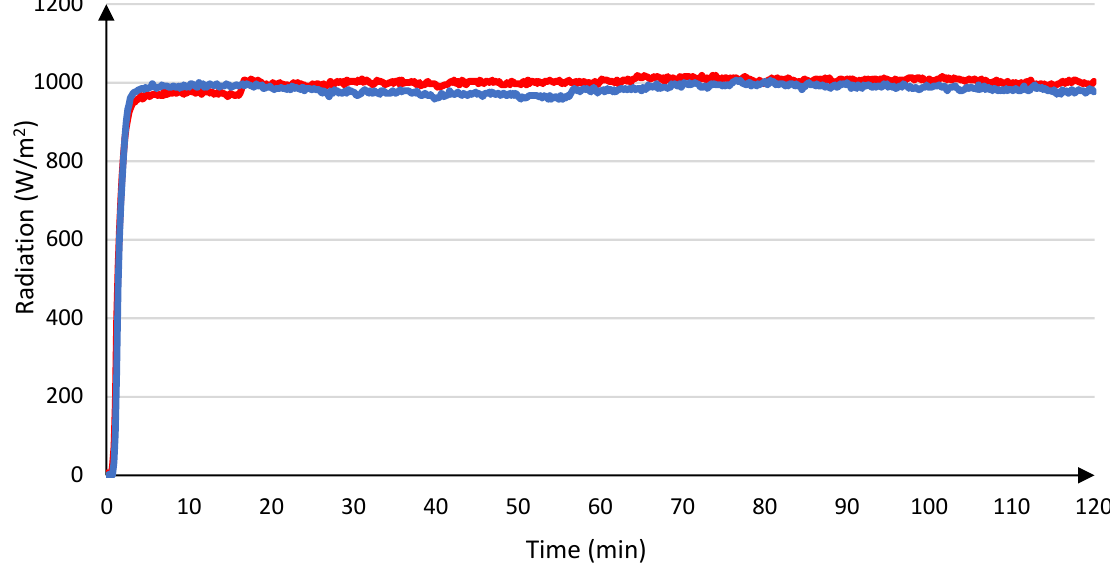
one the enhanced panel. After a ramping of about 3 min, necessary to the lamps to reach the nominal power, the simulated radiation was around 1000 W/m 2 .